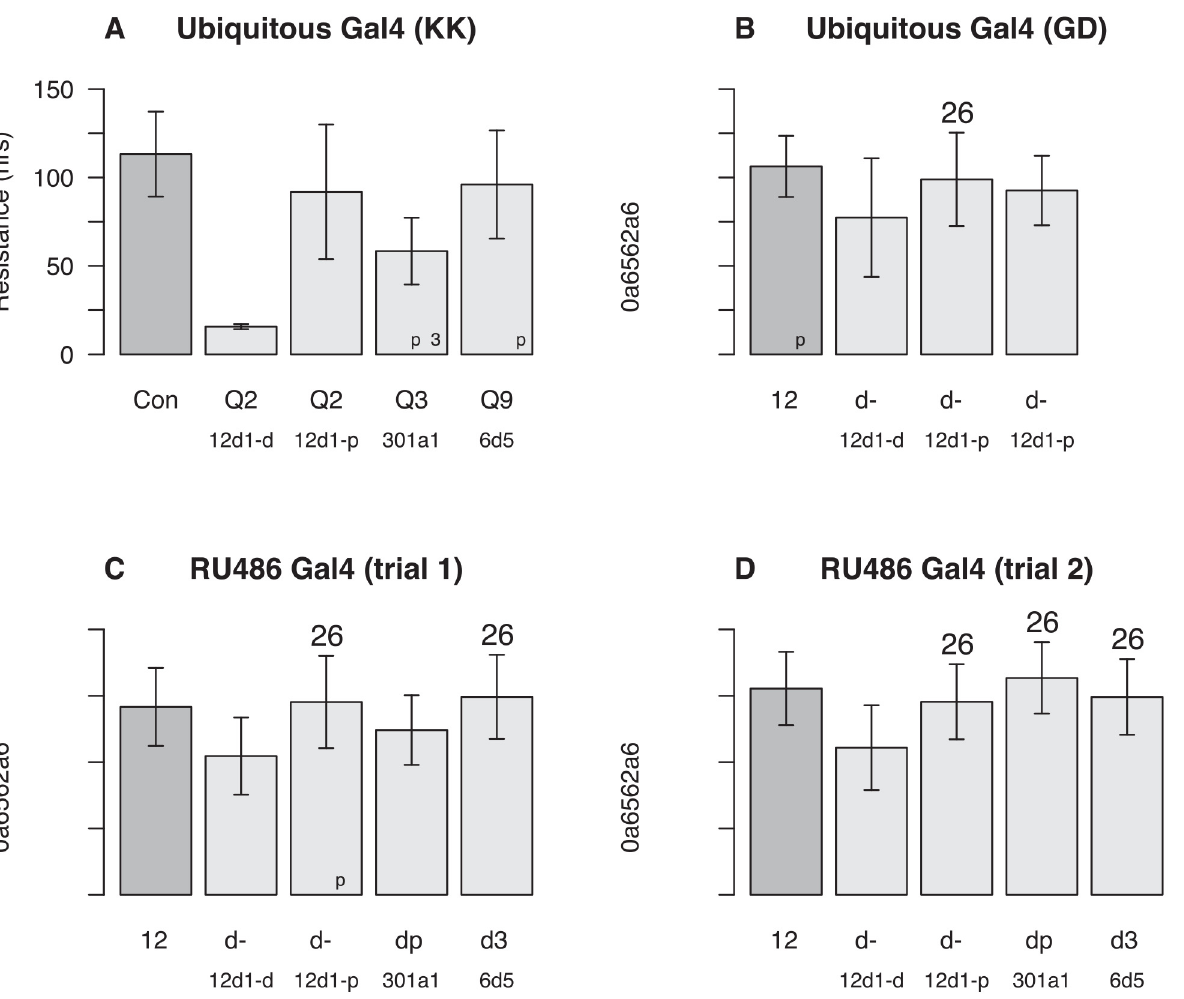
Fig 3. Effects of single gene RNAi knockdown experiments. Gal4-UAS-RNAi female progeny of several genotypes were tested in our caffeine resistance assay against control strains ("Con"). The genes tested were Cyp12d1-d and Cyp12d1-d under QTL Q2, Cyp301a1 under Q3, and Cyp6d5 and under Q9. Each bar represents the mean lifespan ( ± 1-SD) in the assay across a number of genetically-identical individuals (sample size is in the bottom right corner of each bar), and asterisks represent the significance of Welch's t -test comparing each RNAi genotype to its respective control ( ns = not significant, * p < 0.01, ** p < 0.001, *** p < 10 − 10 ). ( A ) Driving Gal4 using a ubiquitous promoter with KK-UAS lines. Left-to-right the VDRC stock numbers of the test genotypes are 60100, 109248, 109256, 109771, and 107641. ( B ) Driving Gal4 using a ubiquitous promoter with GD-UAS lines. Left-to-right the VDRC stock numbers of the test genotypes are 60000, 50507, 21235, and 49269. ( C and D ) Driving Gal4 ubiquitously in adults using an RU486-inducible promoter in two independent trials, the first ( C ) with flies on RU486 for 24 hours prior to the assay and throughout, and the second ( D ) with flies on RU486 for 48 hours prior to the assay and throughout. Genotypes tested are the same as those depicted in ( A